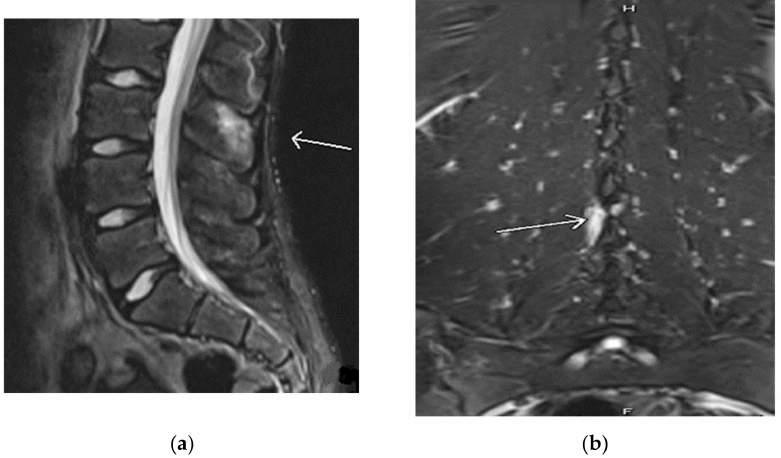
Figure 2. ( a ) Magnetic resonance imaging (MRI) lumbar spine sagittal view shows an arrow pointing to a small focal area of soft tissue edema along the L3 spinous process into the L2-3 interspinous ligament without underlying bone marrow edema, compatible with the earliest findings of "kissing spine" Baastrup’s disease. ( b ) MRI lumbar spine coronal view shows an arrow pointing to a small focal area of soft tissue edema along the L3 spinous